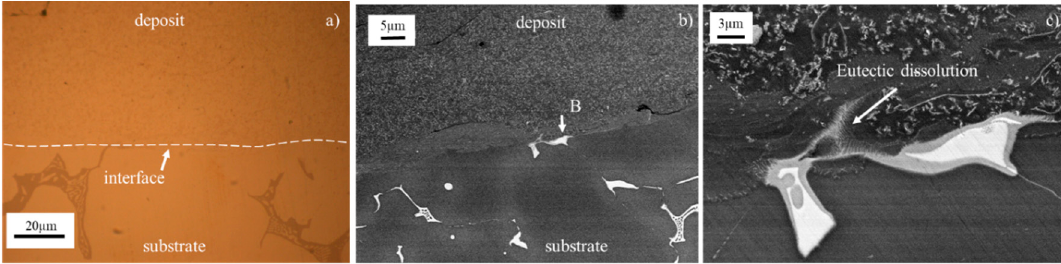
Figure 7. Microstructure near the interface between the substrate and deposit: ( a ) OM and ( b ) SEM micrographs of WE43 deposit, ( c ) magnification of interface (as marked “B” in Figure 7b).